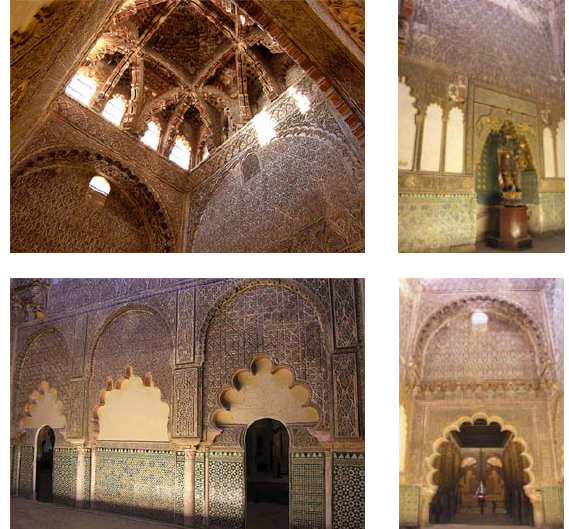
Figure 2. Royal Chapel. Upper left: dome and south and east walls. Upper right: vaulted niche in west wall. Lower left: east side wall. Lower right: south wall with blind and multi foil arches open to the nave of the